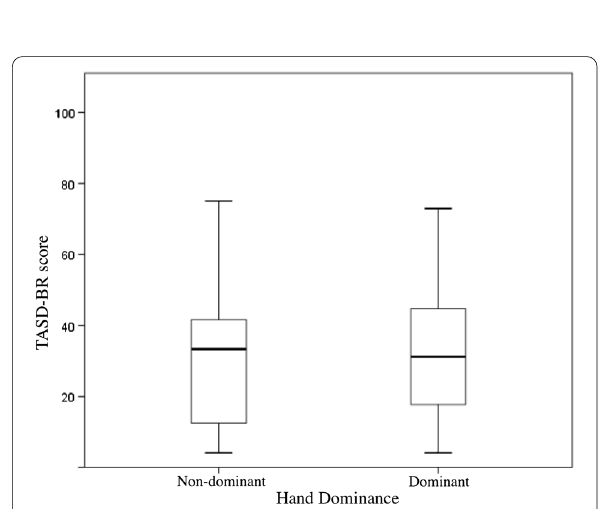
Fig. 2 Box diagram for TASD-BR score, in relation to the dominant or non-dominant